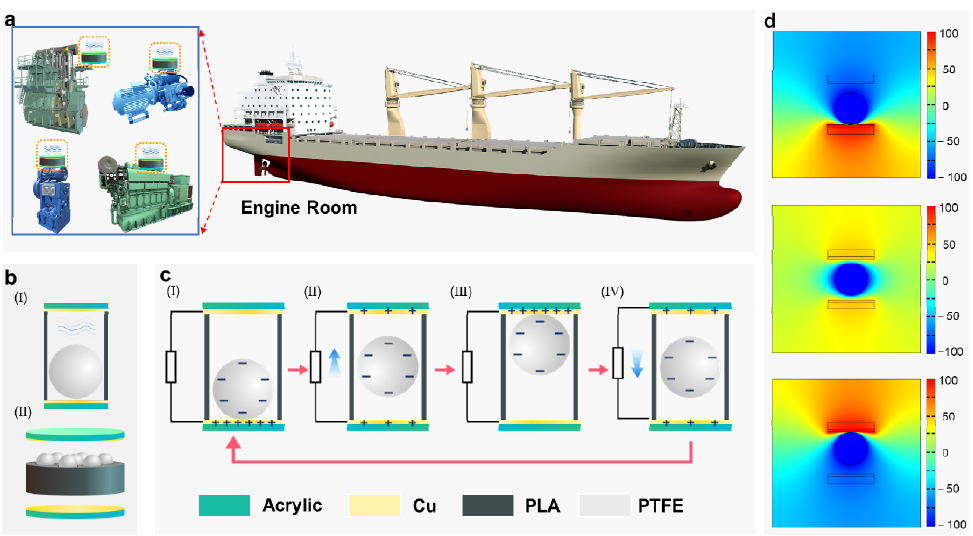
Figure 1. Composition and working principle of the bouncing-ball triboelectric nanogenerator (BB-TENG) sensor. ( a ) Schematic diagram of BB-TENG sensor applied to ship equipment vibration monitoring; ( b ) structure of the BB-TENG sensor; ( c ) working principle of the BB-TENG sensor; and ( d ) the electric potential distribution on the BB-TENG sensor by COMSOL Multiphysics ® (Version 5.5, COMSOL Inc., Stockholm,